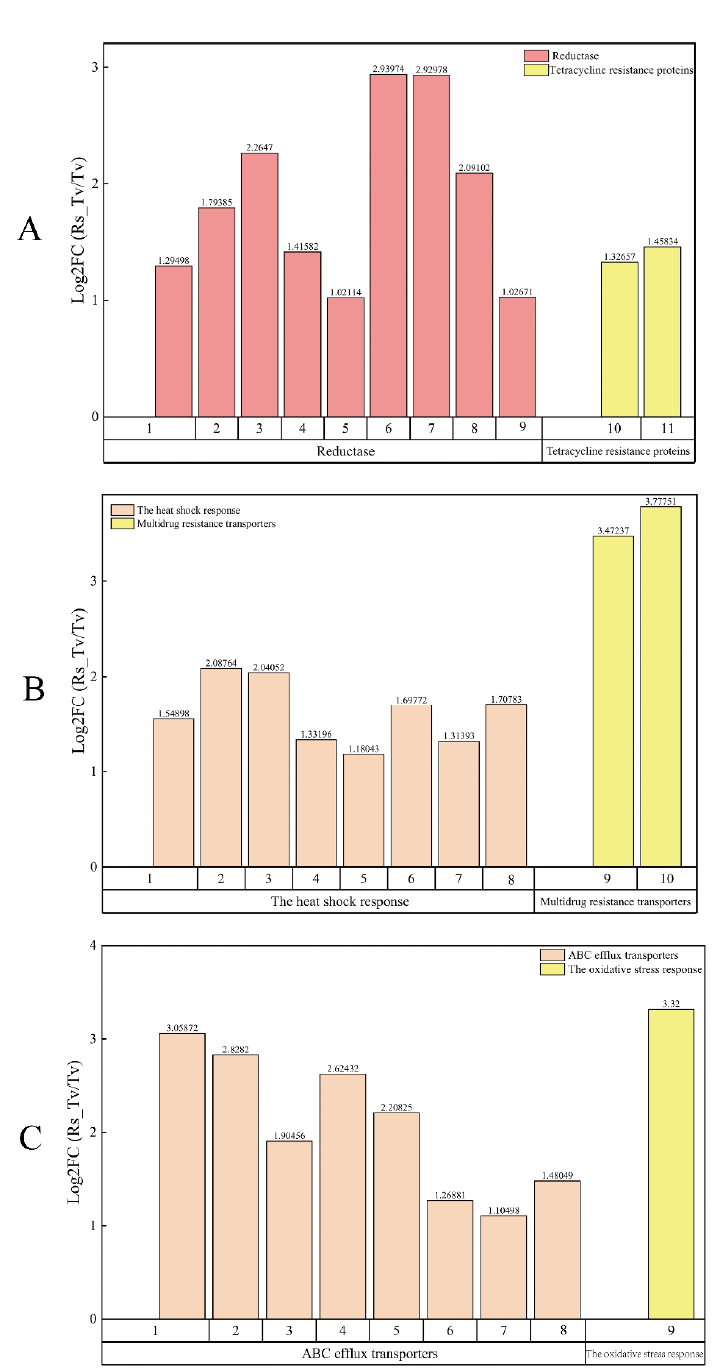
Figure 8. Resistance protein genes from T. virens ZT05. A: 1, 2, 3, 4, 5, 6, 7, 8, 9, 10, and 11 represent